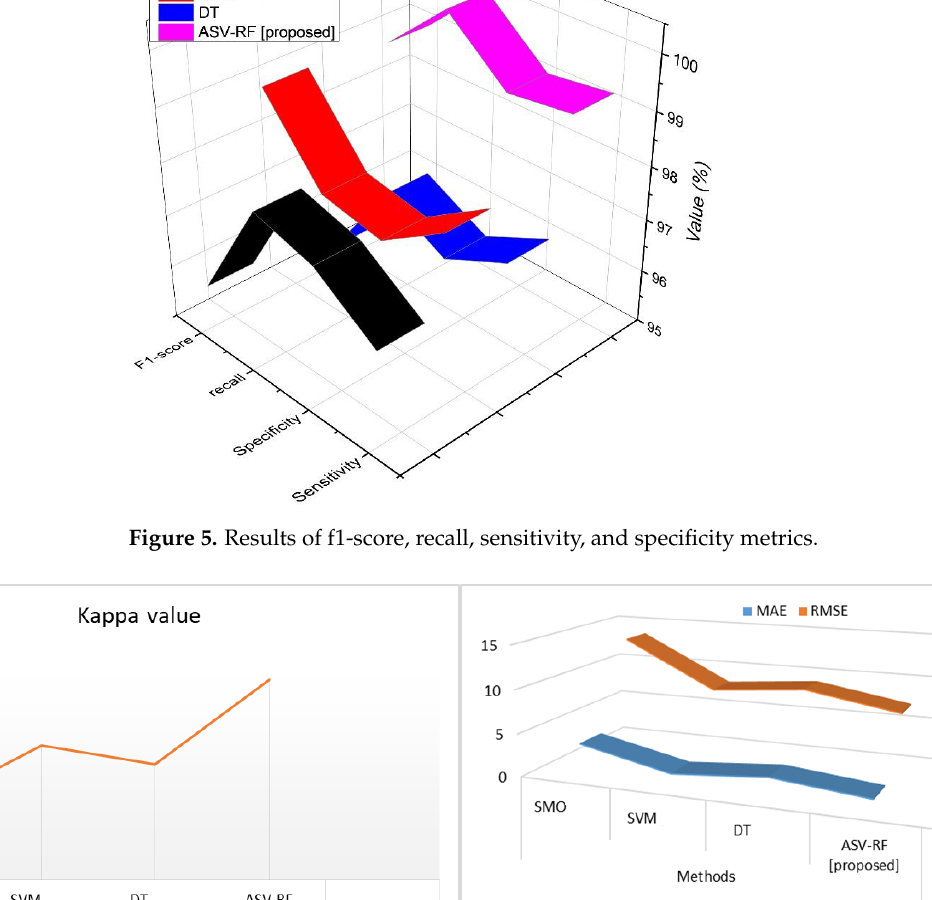
Figure 4. Results of TP, FP, accuracy, and precision metrics.